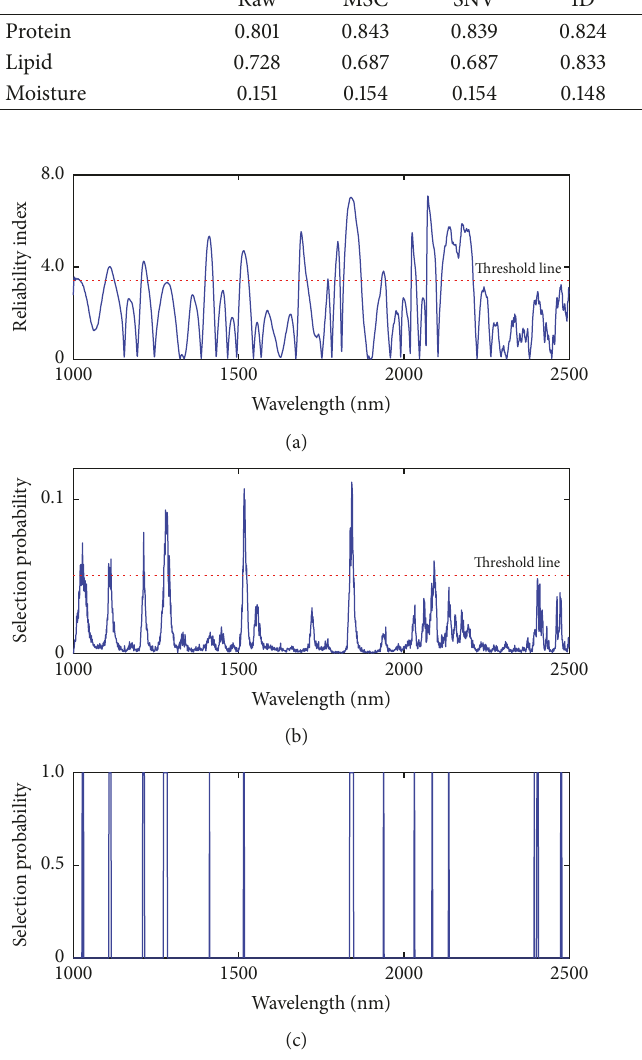
Figure 3: Results of variable screening of protein dataset by (a) MC- UVE, (b) RF, and (c) CARS.